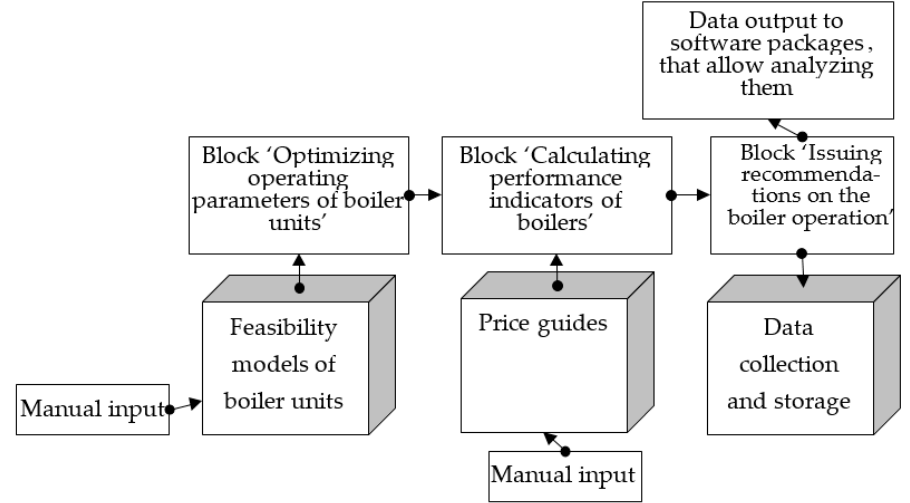
Figure 3. Explanatory Diagram. Software Product for Optimizing the Operating Modes of Industrial Power Plants Boiler Units.